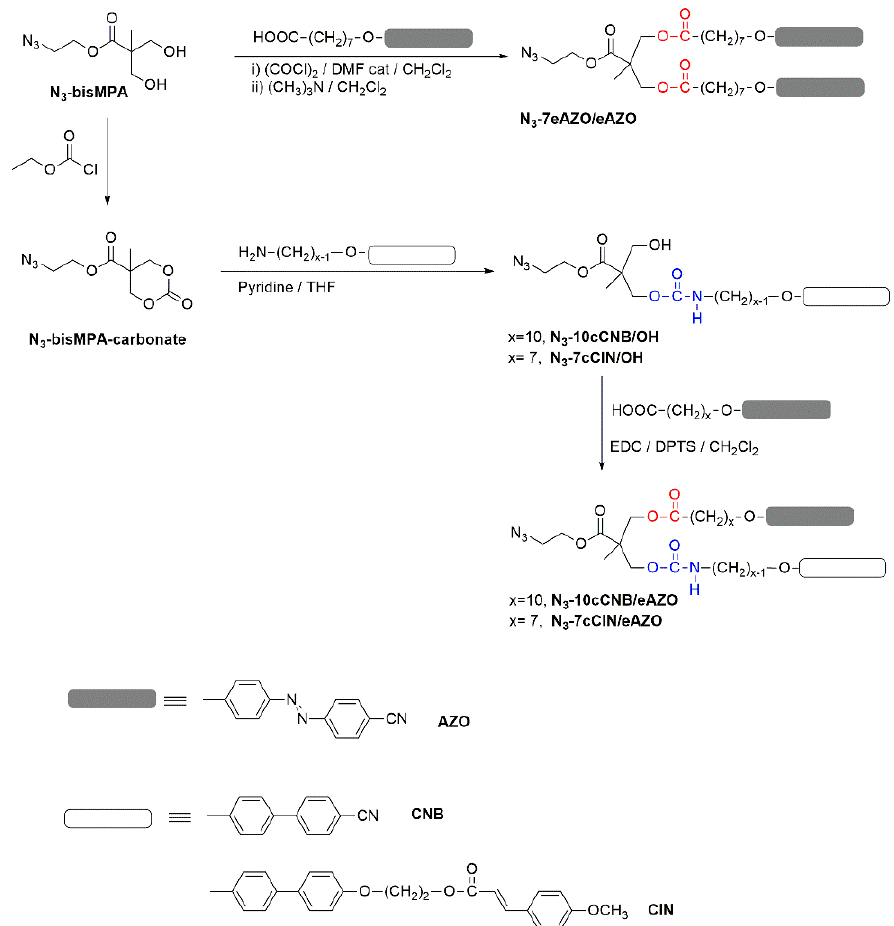
Figure 1. General road map for the synthesis of azides series. Table 1. Transition Temperatures of